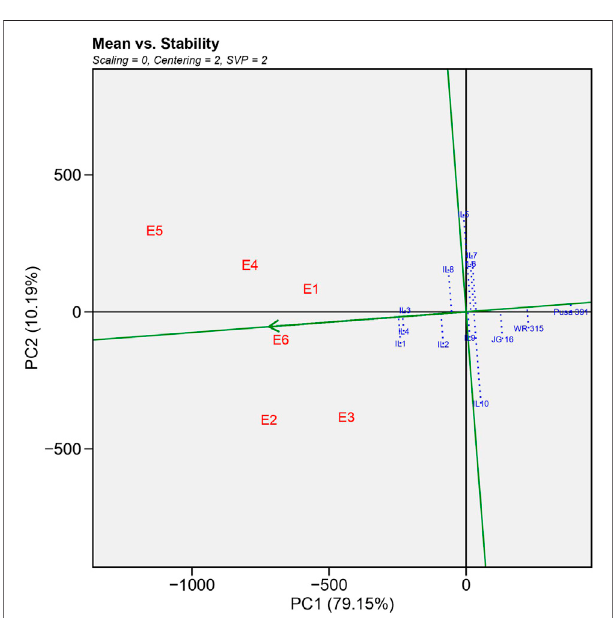
FIGURE 2 | Average-environment coordination (AEC) view showing the mean yield performance and stability of different genotypes based on genotype and genotype interaction (GGE)-biplot